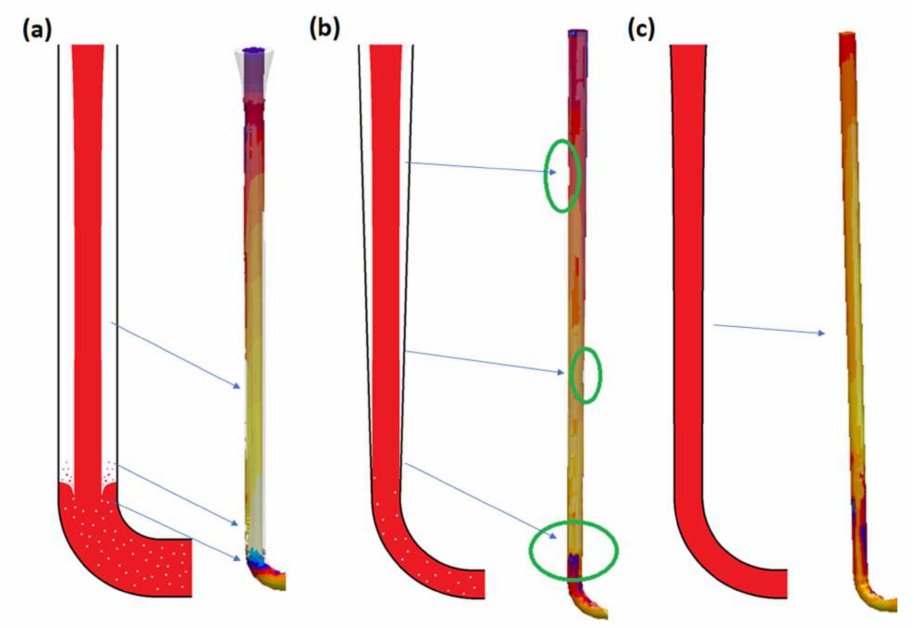
Figure 15. Characteristic points in non-tapered ( a ), straight tapered ( b ), and hyperbolically tapered ( c )